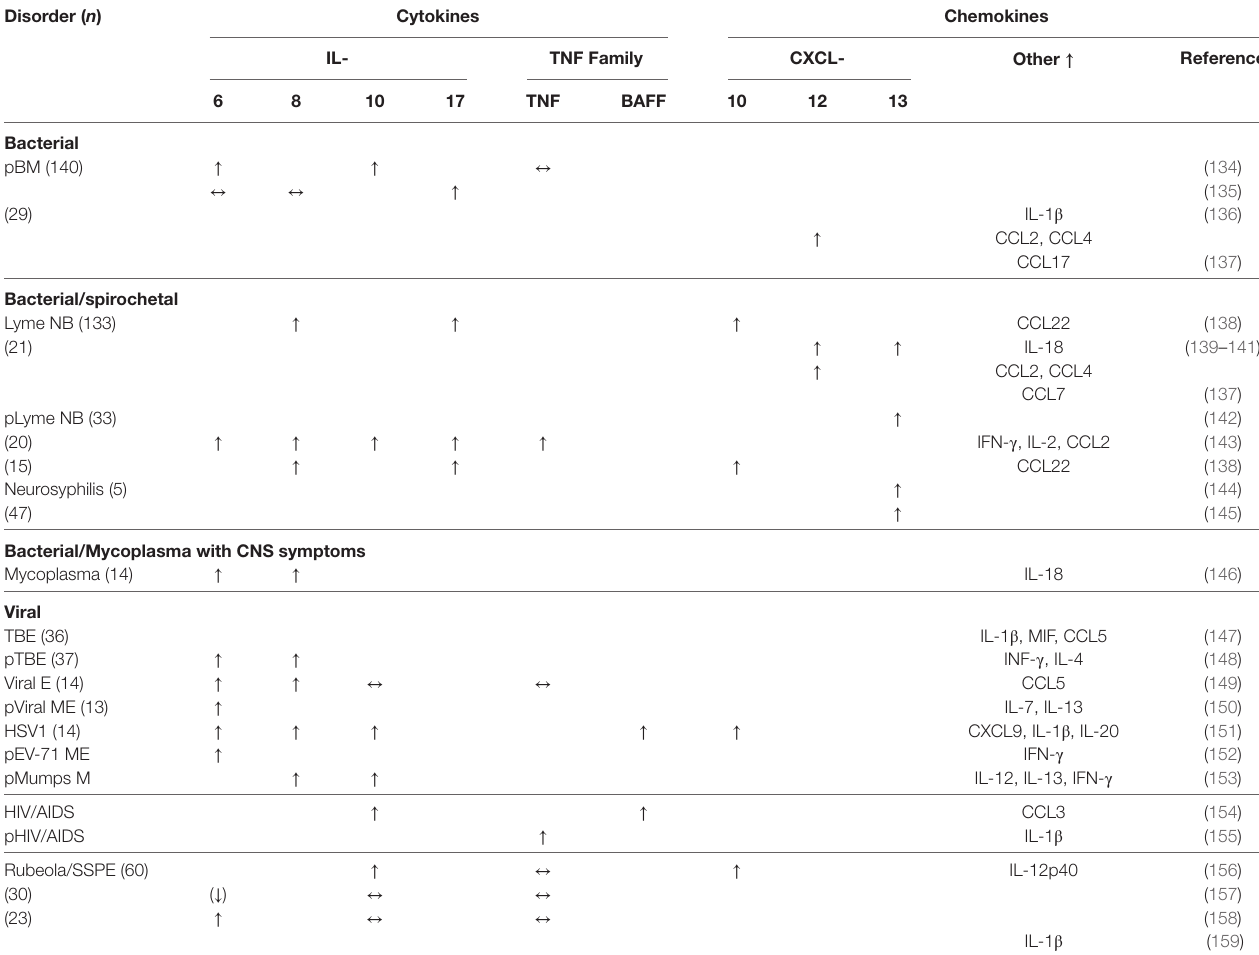
TABle 7 | Cerebrospinal fluid chemo/cytokine profile in CNS